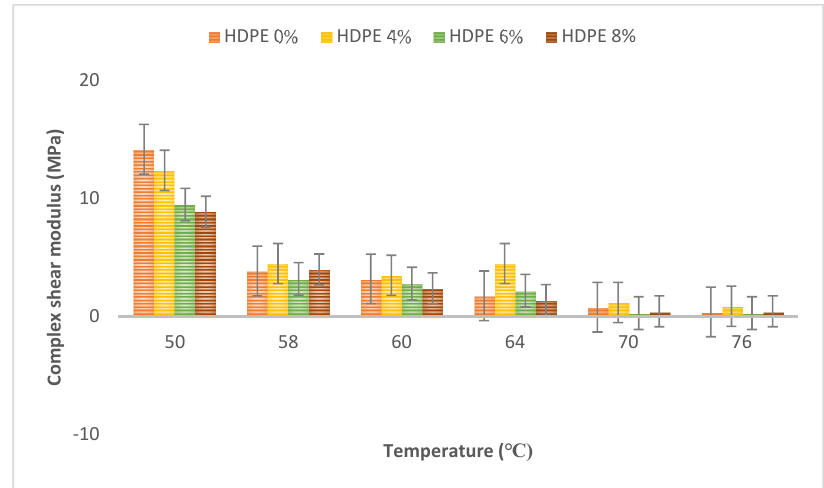
Figure 11. HDPE waste plastic effect on the complex shear modulus.